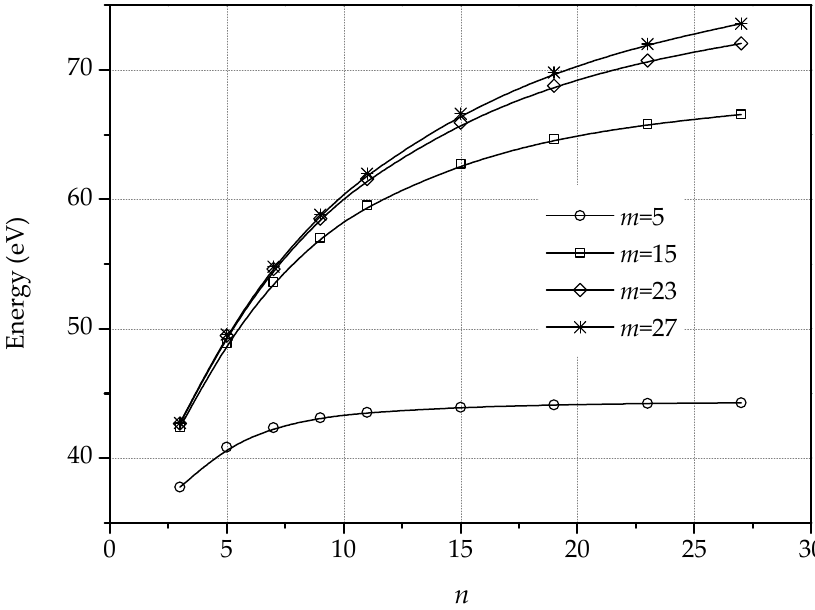
Figure 11. Stored energy of periodic dislocation quadrupoles as a function of dipole sizes, n , for different separation between dislocation lines, m , using the harmonic model.